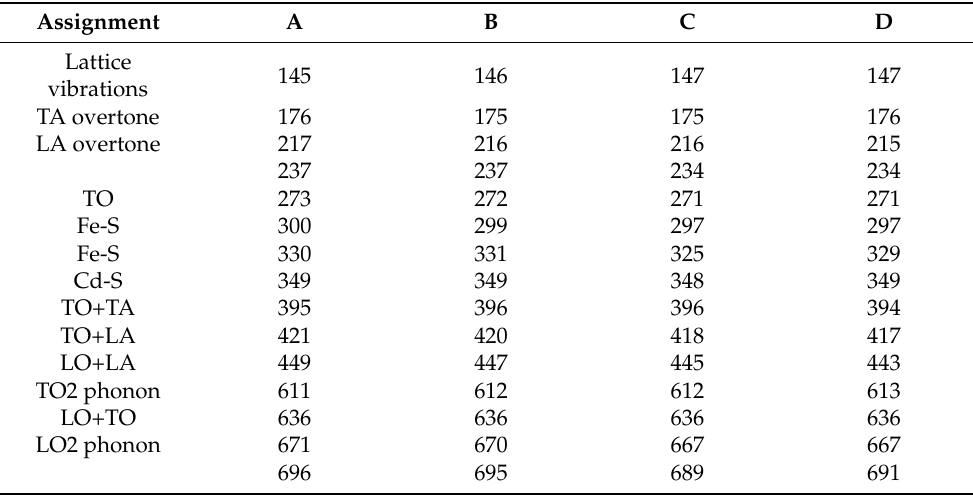
Table 3. Assignment of Raman bands in the studied sphalerite samples